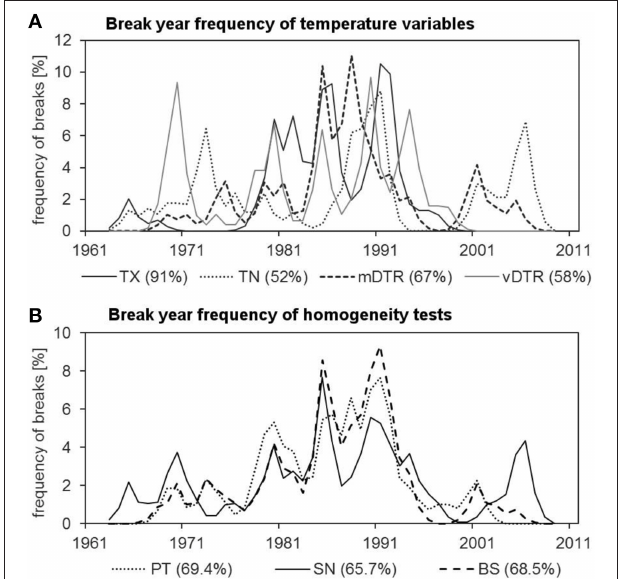
FIGURE 4 | Illustration of the frequency of break years within 1961–1990 for (A) the four analyzed variables TN, TX, mDTR, and vDTR and (B) for the conducted homogeneity tests (PT, Pettitt test; SN, Standard normal homogeneity test SNHT; BS, Buishand test). The percentage of tested data series with breaks is given in